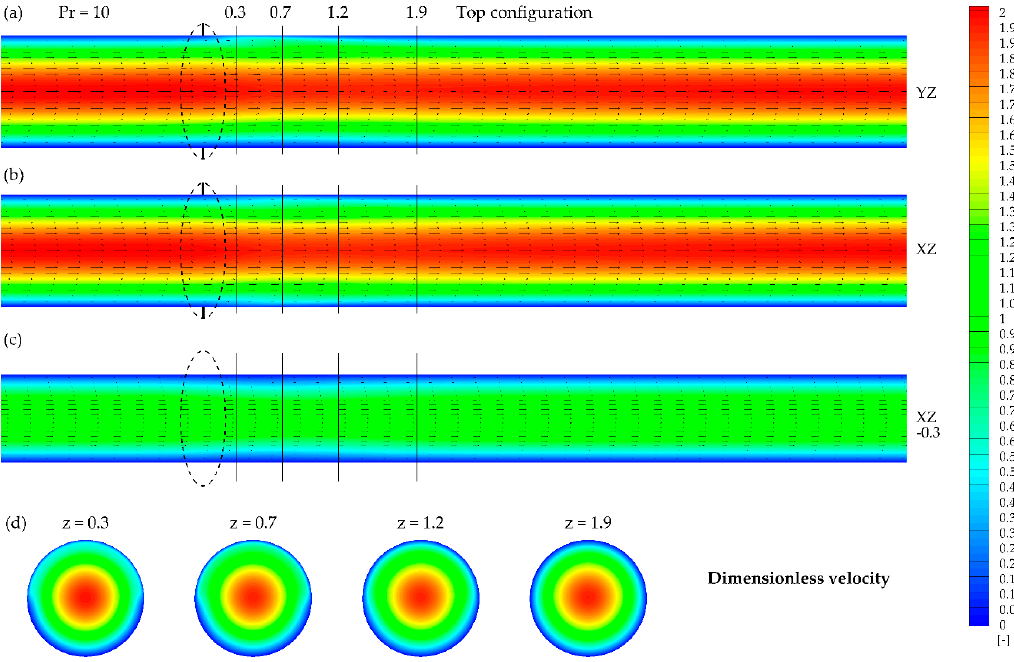
Figure 8. Dimensionless velocity contours and vectors obtained for Pr = 10 and top configuration in the presence of the magnetic field at: ( a ) YZ plane, ( b ) XZ plane, ( c ) XZ plane ( y = − 0.3), ( d ) XY planes at given z .